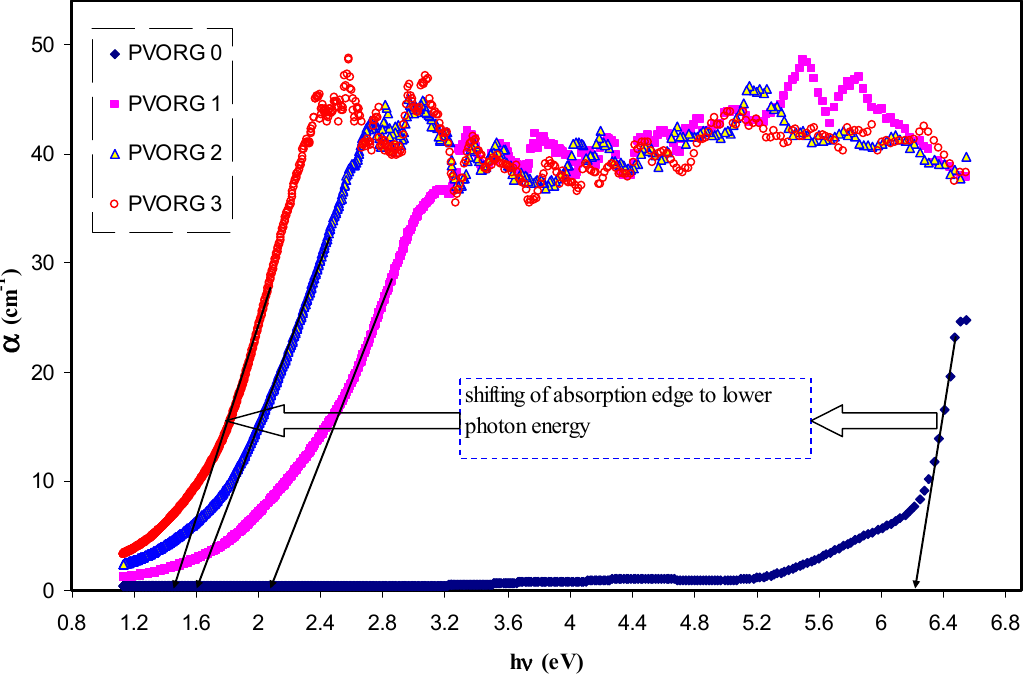
Figure 8. Absorption coefficient vs photon energy for pure PVA (PVORG0) and PVA composite films. Table 1. Absorption edge values for pure PVA (PVORG0) and PVA composite films.